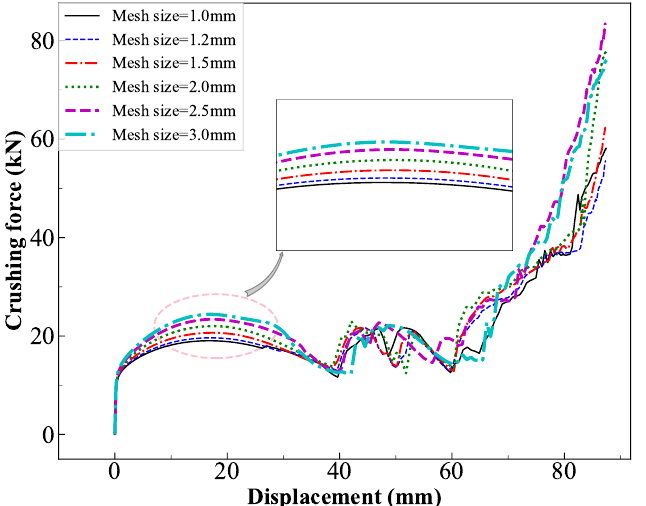
Figure 6. The crushing force versus displacement curves of D2-1 with a mesh size decreasing from 3 to 1